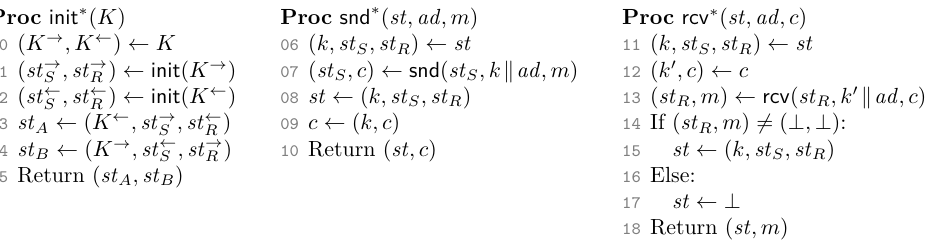
Figure 9: A bidirectional channel Ch ∗ = ( init ∗ , snd ∗ , rcv ∗ ) built from two instances of a unidirectional channel Ch = ( init , snd , rcv ). It falls prey to a purely passive (IND-2CPA) attack, even if Ch is secure against active adversaries